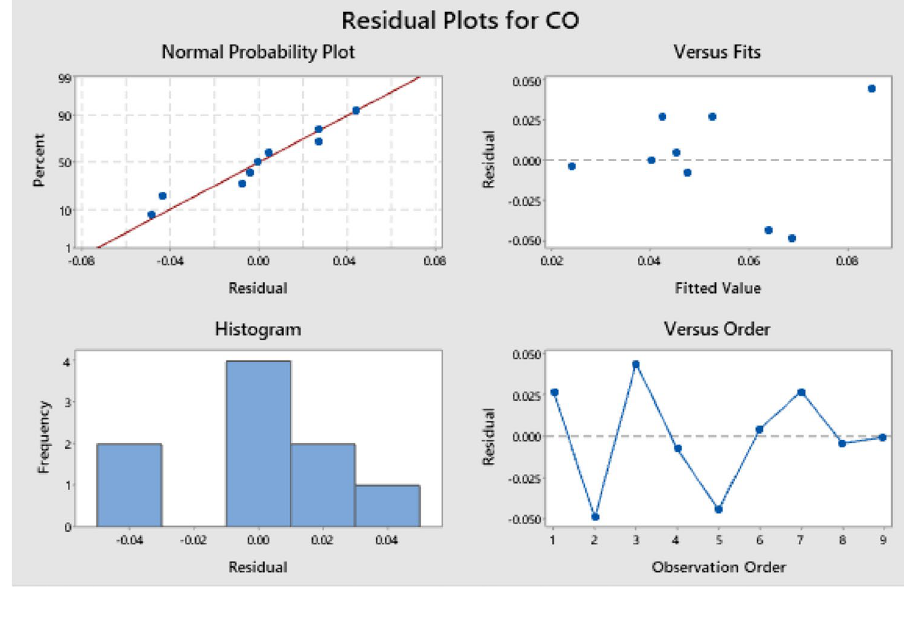
Fig. 15 Residual plot for CO with